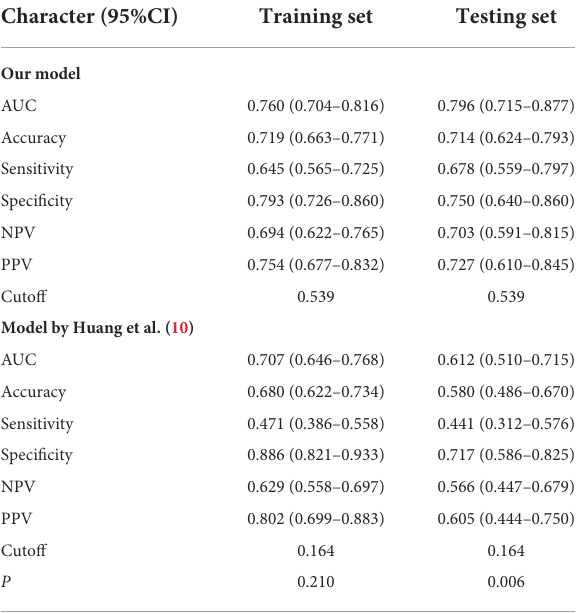
TABLE 5 The predictive value of the prediction model.